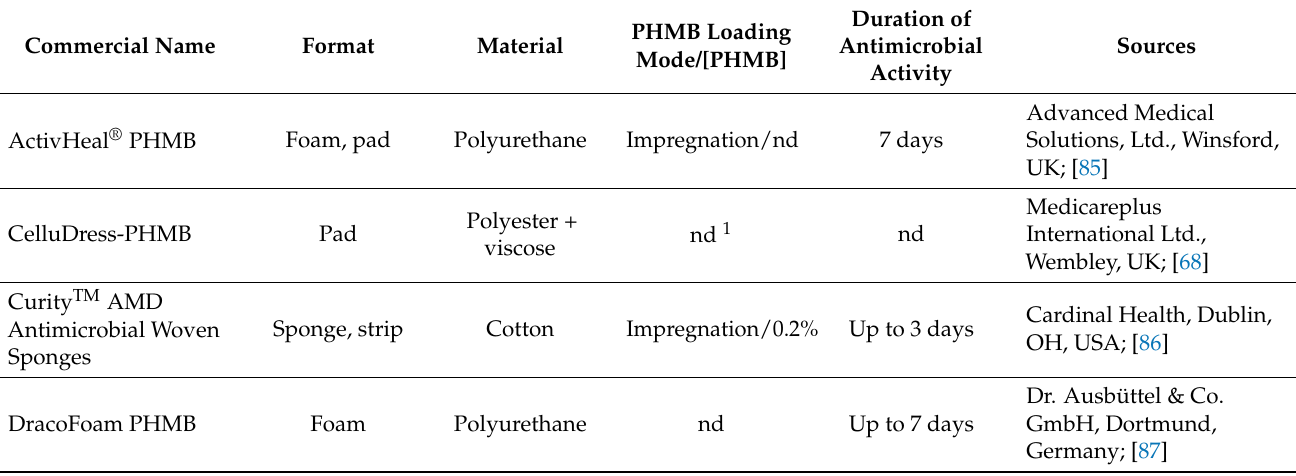
Table 2. Commercially available PHMB-releasing wound dressings (PRWDs), in alphabetical